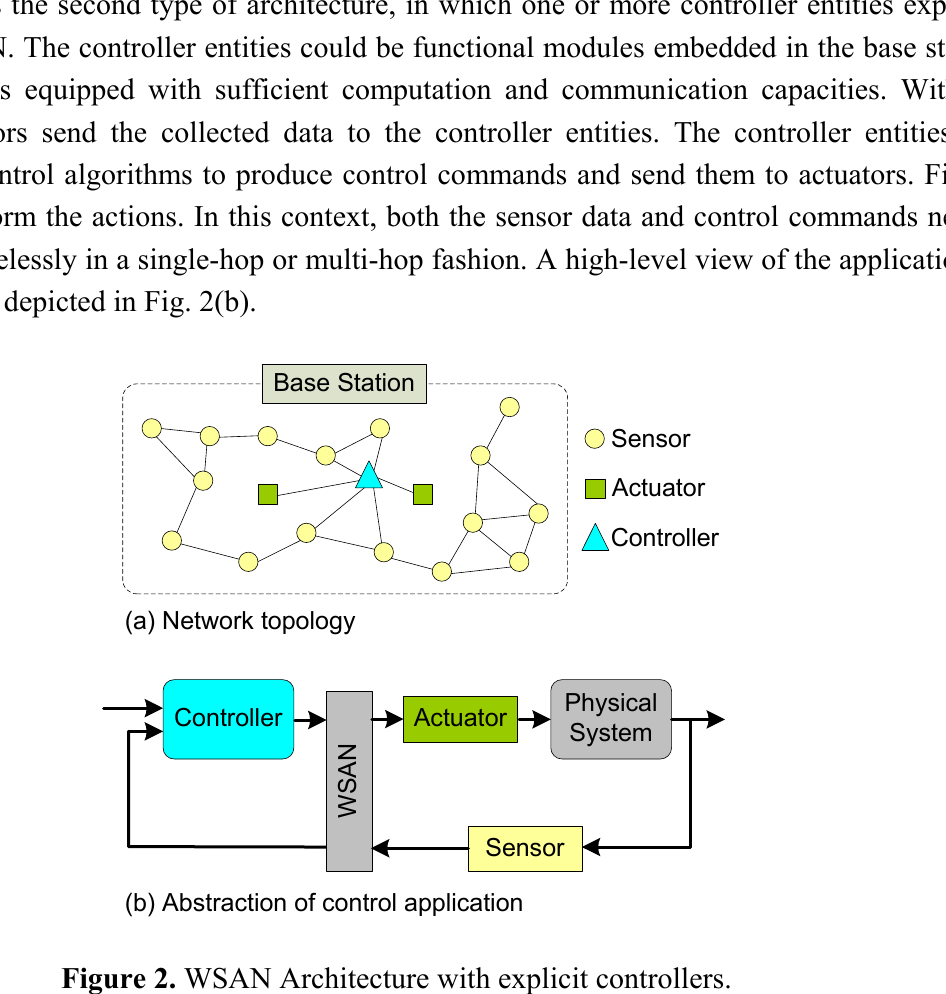
Figure 2. WSAN Architecture with explicit